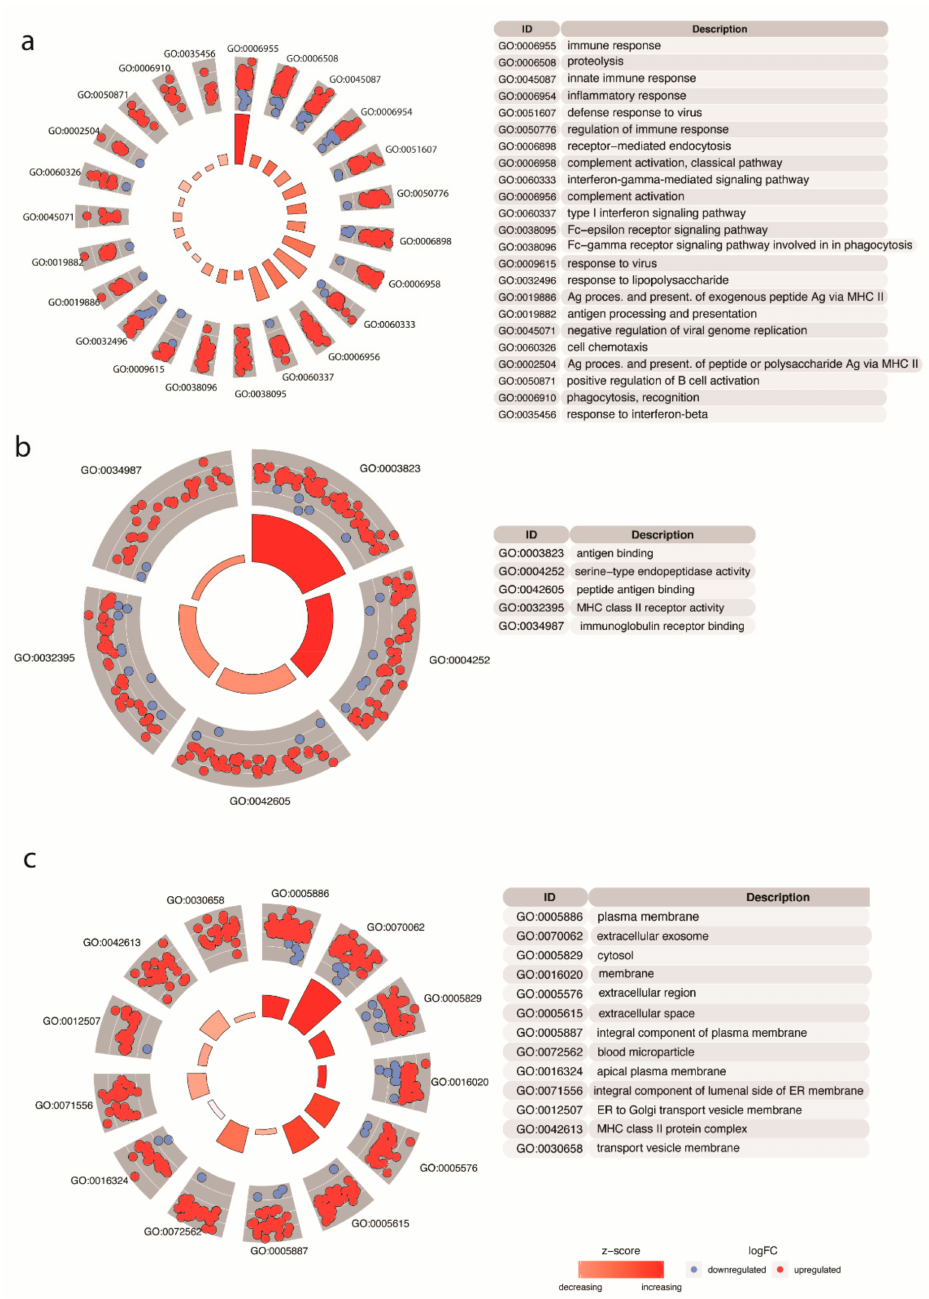
Figure 2. Results of functional enrichment analysis. The outer circle shows a scatter plot of each term, including their corresponding genes (blue dots down-regulated and red dot up-regulated). Z-score indicates the tendency to increase or decrease each of the gene ontology (GO) terms based on the ratio of the di ff erentially expressed genes. Only the significant terms are displayed in the three main categories: ( a ) biological process, ( b ) cellular components, and ( c ) molecular